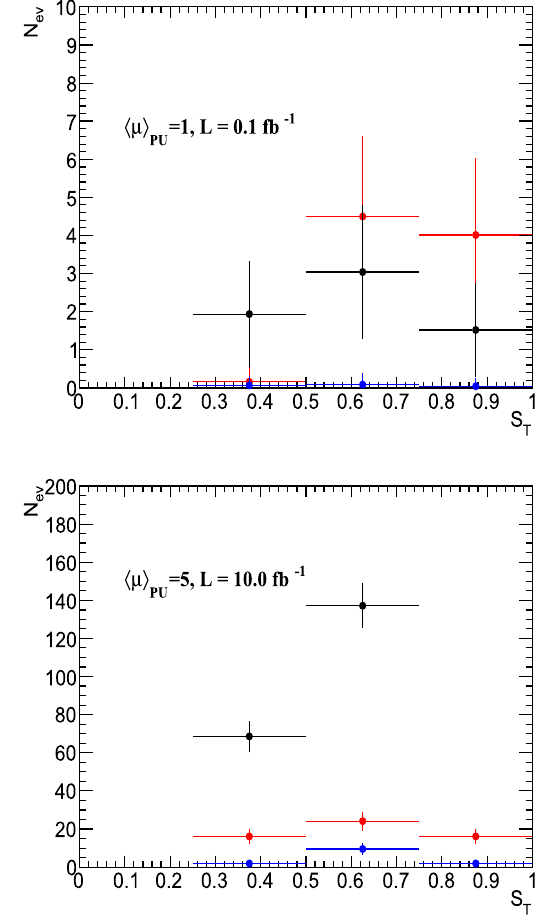
detector-level cuts in Eq. (9) for four luminosity scenarios. Only statis- tical uncertainties are shown, estimated using expected event